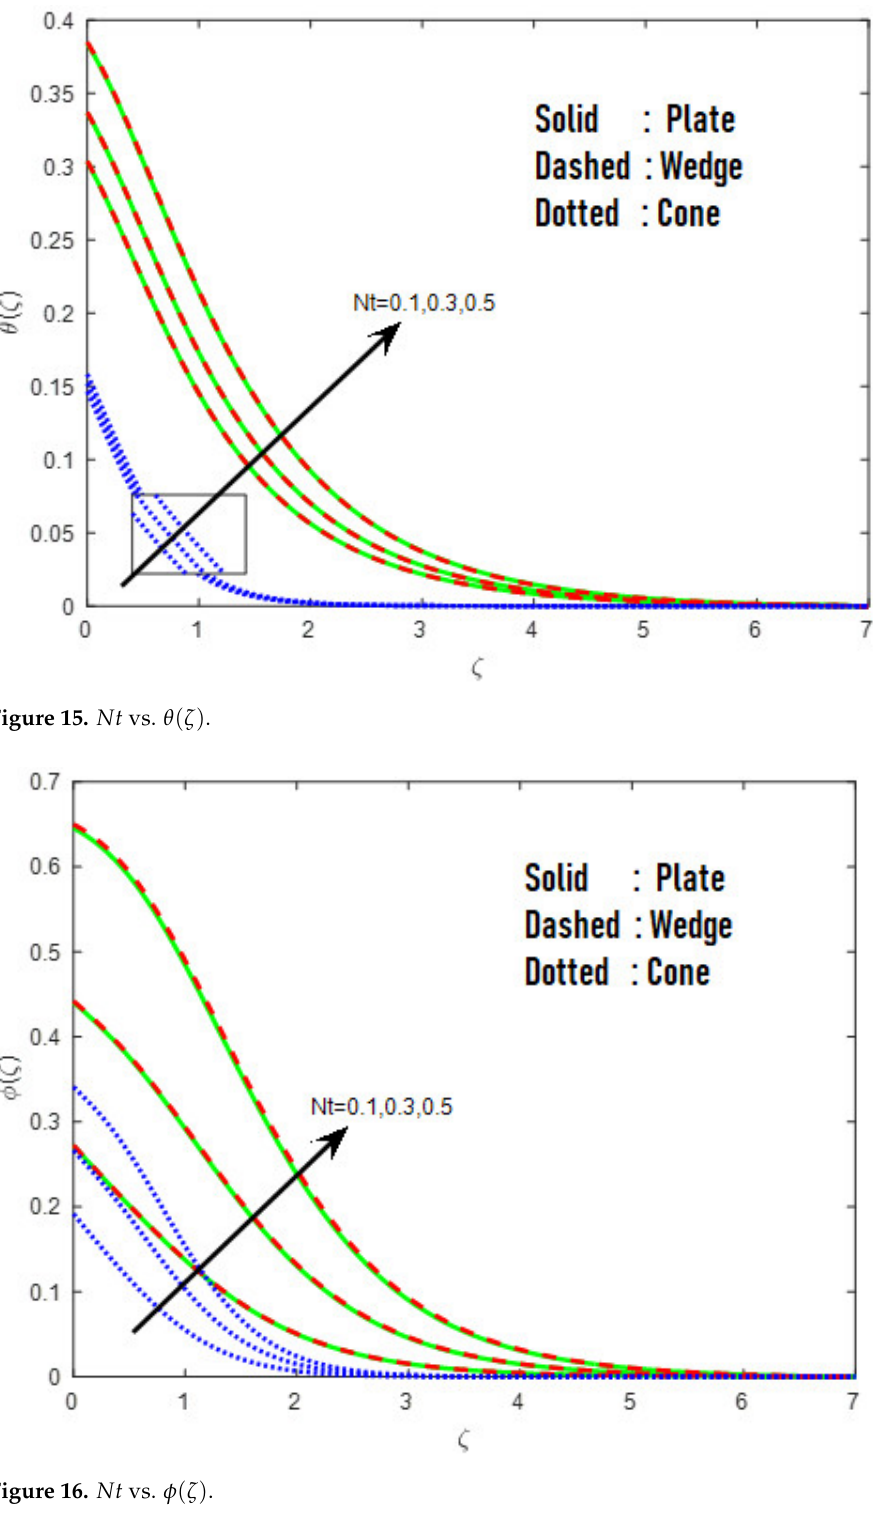
Figure 16. Nt vs.